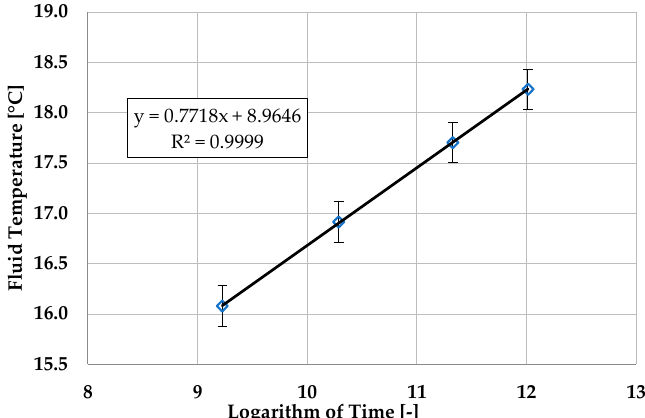
Figure 13. Depth-averaged temperatures as the function of the logarithm of time. The fitting line is employed for a depth-averaged conductivity estimation.